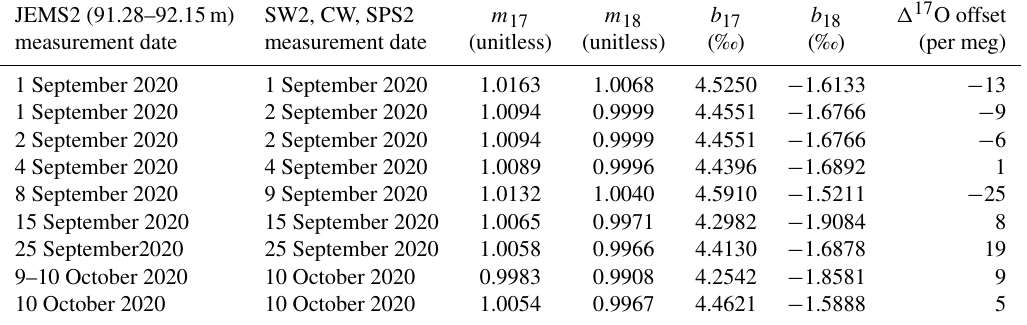
Table 2. Sequence of CFA–CRDS measurements, including calibration information and calibration offset determined by Eq. (5) for 1.39cm resolved data. Note that the long reference water measurement of SW2 used to generate Fig. 7 was made on 18 September 2020. Also note that none of the reference water measurements on 8 September were acceptable to use for calibration and that the large calibration offset for this measurement may be attributed to instrument drift or a change in CFA conditions between 8 and 9 September. Notable flow